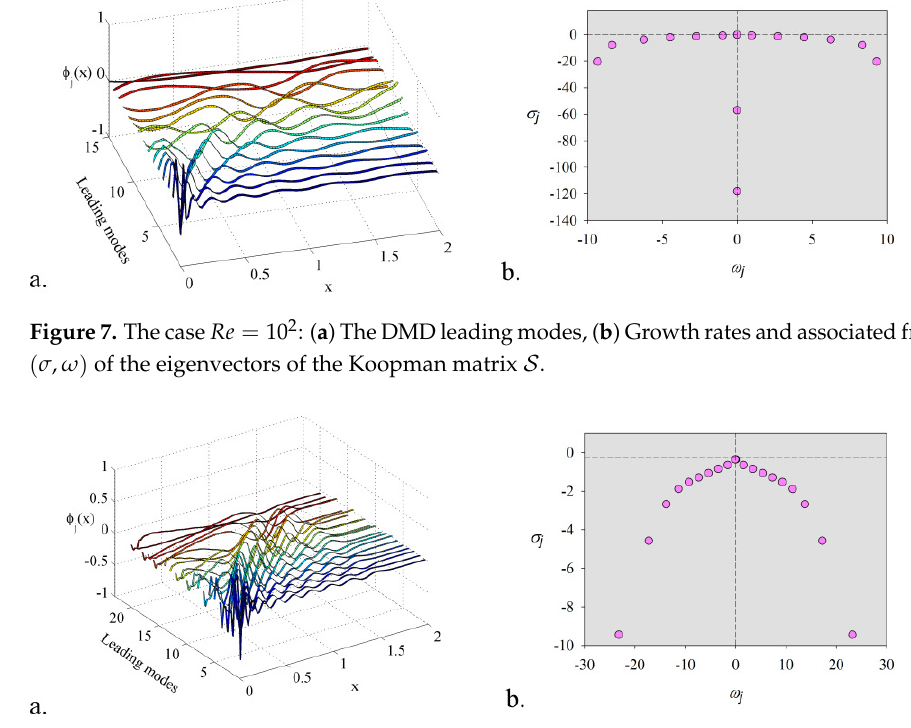
Figure 8. The case Re = 10 3 : ( a ) The DMD leading modes, ( b ) Growth rates and associated frequencies ( σ , ω ) of the eigenvectors of the Koopman matrix S